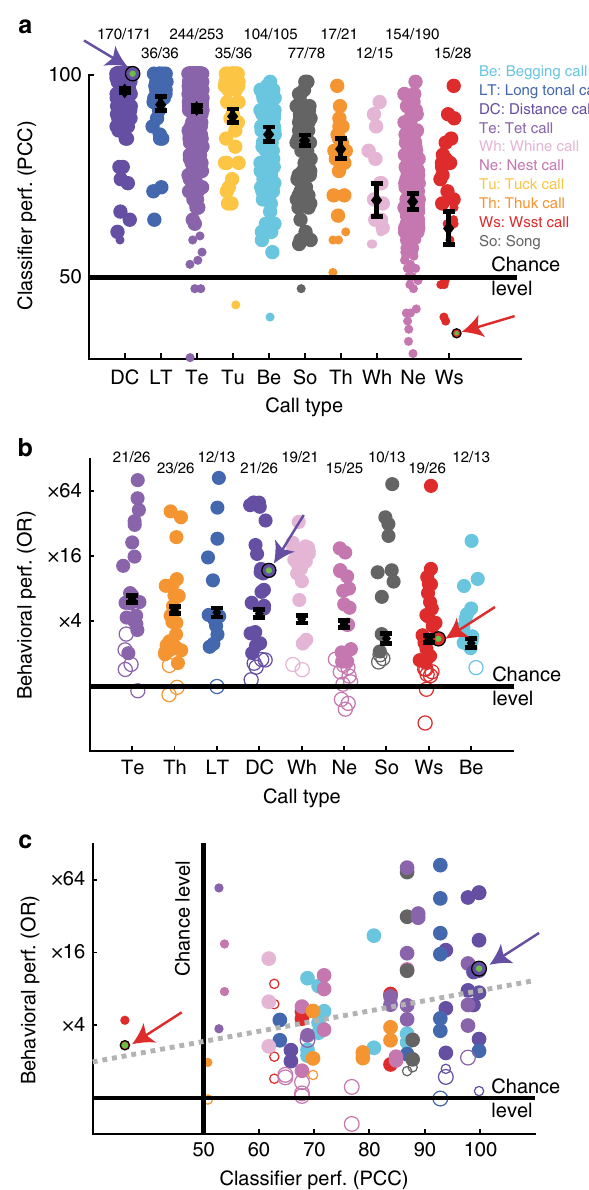
Fig. 4 Vocalizer discrimination within each call type. a Each circle corresponds to the performance of the regularized LDA at discriminating a pair of vocalizers (large circles: acoustic discrimination of pairs of vocalizers signi fi cantly above chance tested by binomial test at p < 0.05 on PCC; effect of call type: likelihood ratio test (LRT) on Generalized Linear Mixed Effects models (GLME), χ 2 9 = 4406.5, p = 2.2×10 − 16 ); b Each circle corresponds to the behavioral performance of bird subjects at discriminating pairs of vocalizers in a single-call-type test ( n = 13). The behavioral performance is measured as the odds ratio, OR ( fi lled circles: OR signi fi cantly above chance tested by exact test as described in Methods; effect of vocalizer: LRT on GLME, χ 2 1 = 2814.2, p = 0; effect of call type: LRT on GLME, χ 2 8 = 700.7, p = 0; see Supplementary Table 1 for all statistical results); c Correlation between the behavioral and the classi fi er performance for discriminating pairs of vocalizers (regression line indicated by the gray dotted line: ρ = 0.2381, p = 0.0058, two-tail Spearman coef fi cient, n = 79). The performances of the subject shown in Fig. 3 and of the classi fi er on the same stimuli are identi fi ed by arrows and small green dots in all three panels. Black diamonds and error bars in a and b : estimates of the GLME coef fi cients and their 95% con fi dence intervals. In all three panels, call type is color coded as described in